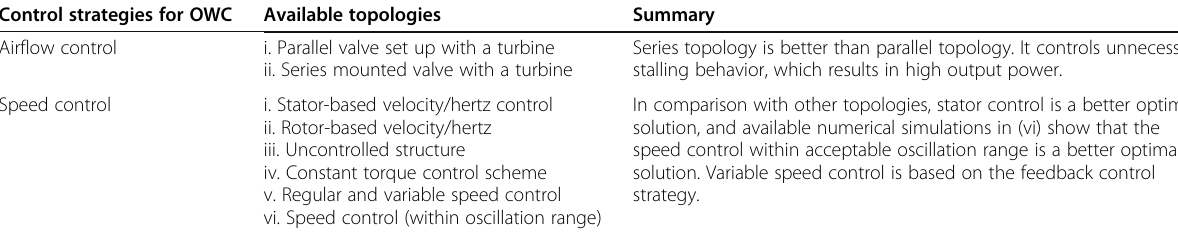
Table 1 Recently developed control strategies for the OWC